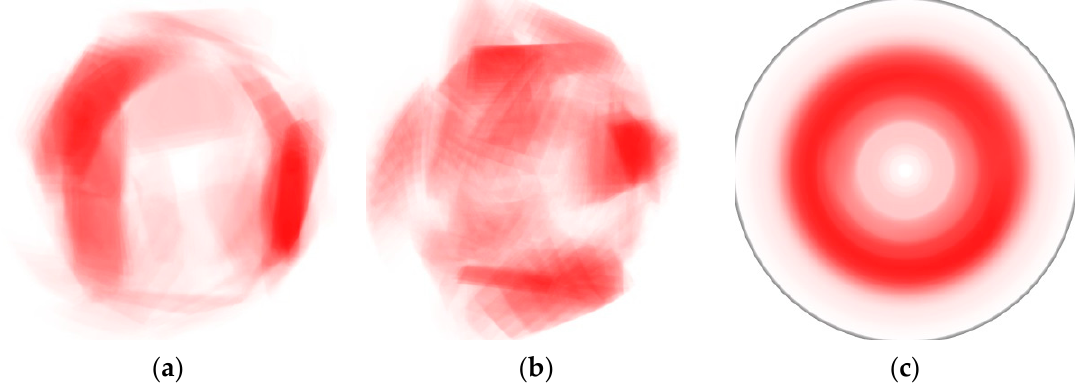
Figure 8. Distribution of the backscattered intensity over the particle projection obtained in the geometrical optics approximation for the beam trajectories with three ( a ) and four ( b ) internal reflections/refraction events averaged for two Euler angles of particle orientations. Here ( c ) is the average over random orientation.